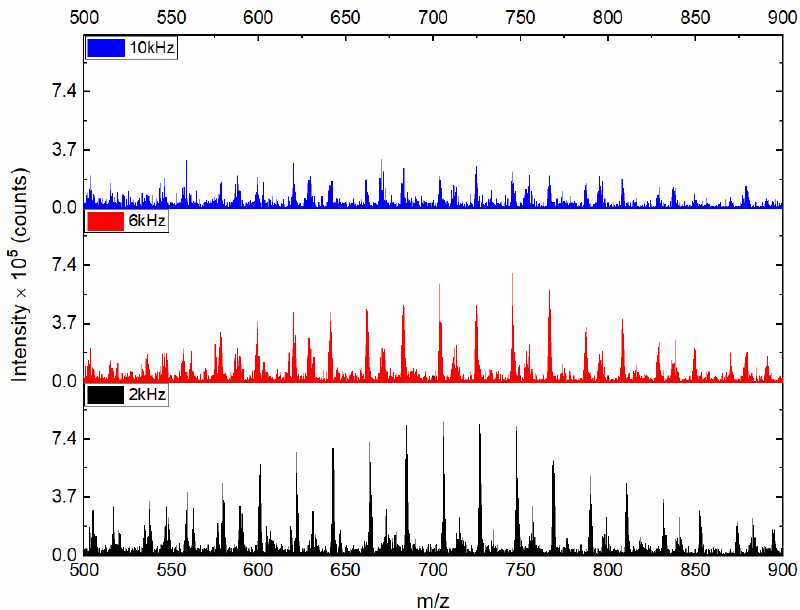
Figure 9. Mass spectra of the pp-PEG films obtained in an atmospheric-pressure DBD working in He with ethylene glycol (EG) vapors at different applied voltage frequencies.